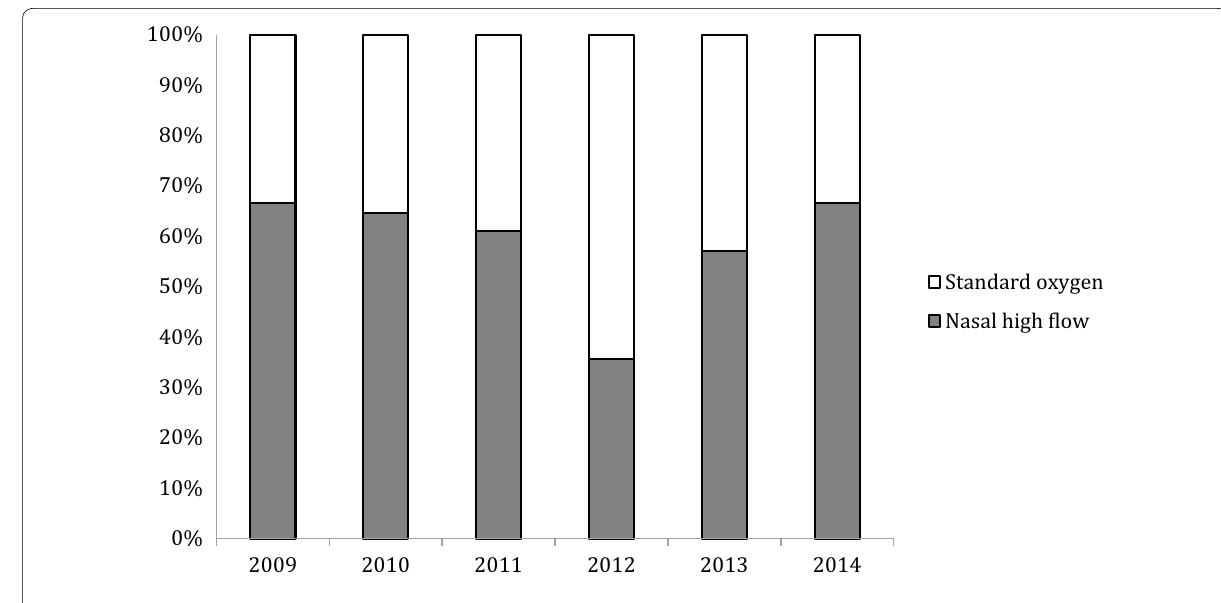
Fig. 2 Proportion of children treated by nasal high flow and standard oxygen from 2009 to 2014 ( p